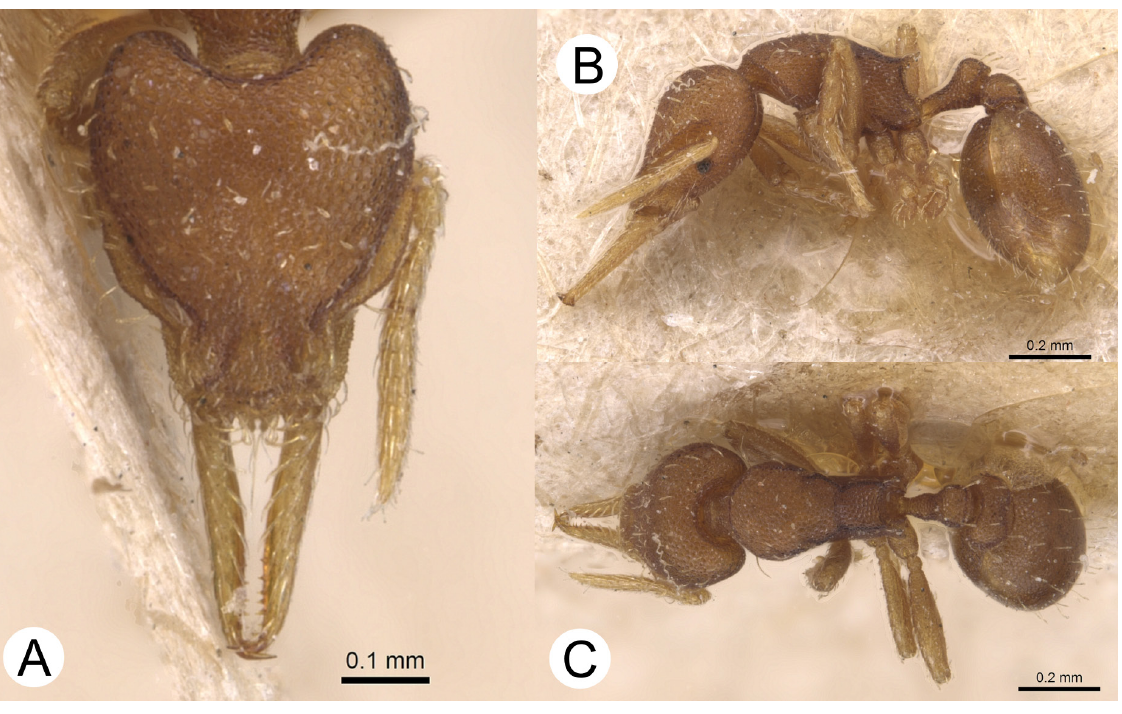
Fig. 5. Lectotype of Strumigenys eggersi Emery, 1890 (CC-BY, CASENT0904936, Will Ericson, from www.antweb.org). A . Head, mandibles and antennae, in dorsal view. B . Full body, in lateral view. C . Full body, in dorsal